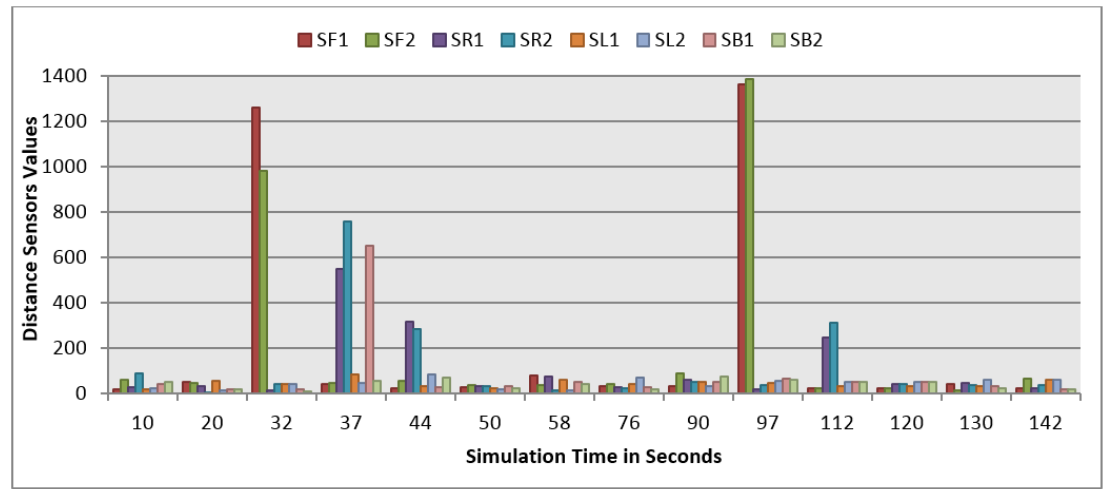
Figure 19. Distance sensor values at different simulation times.